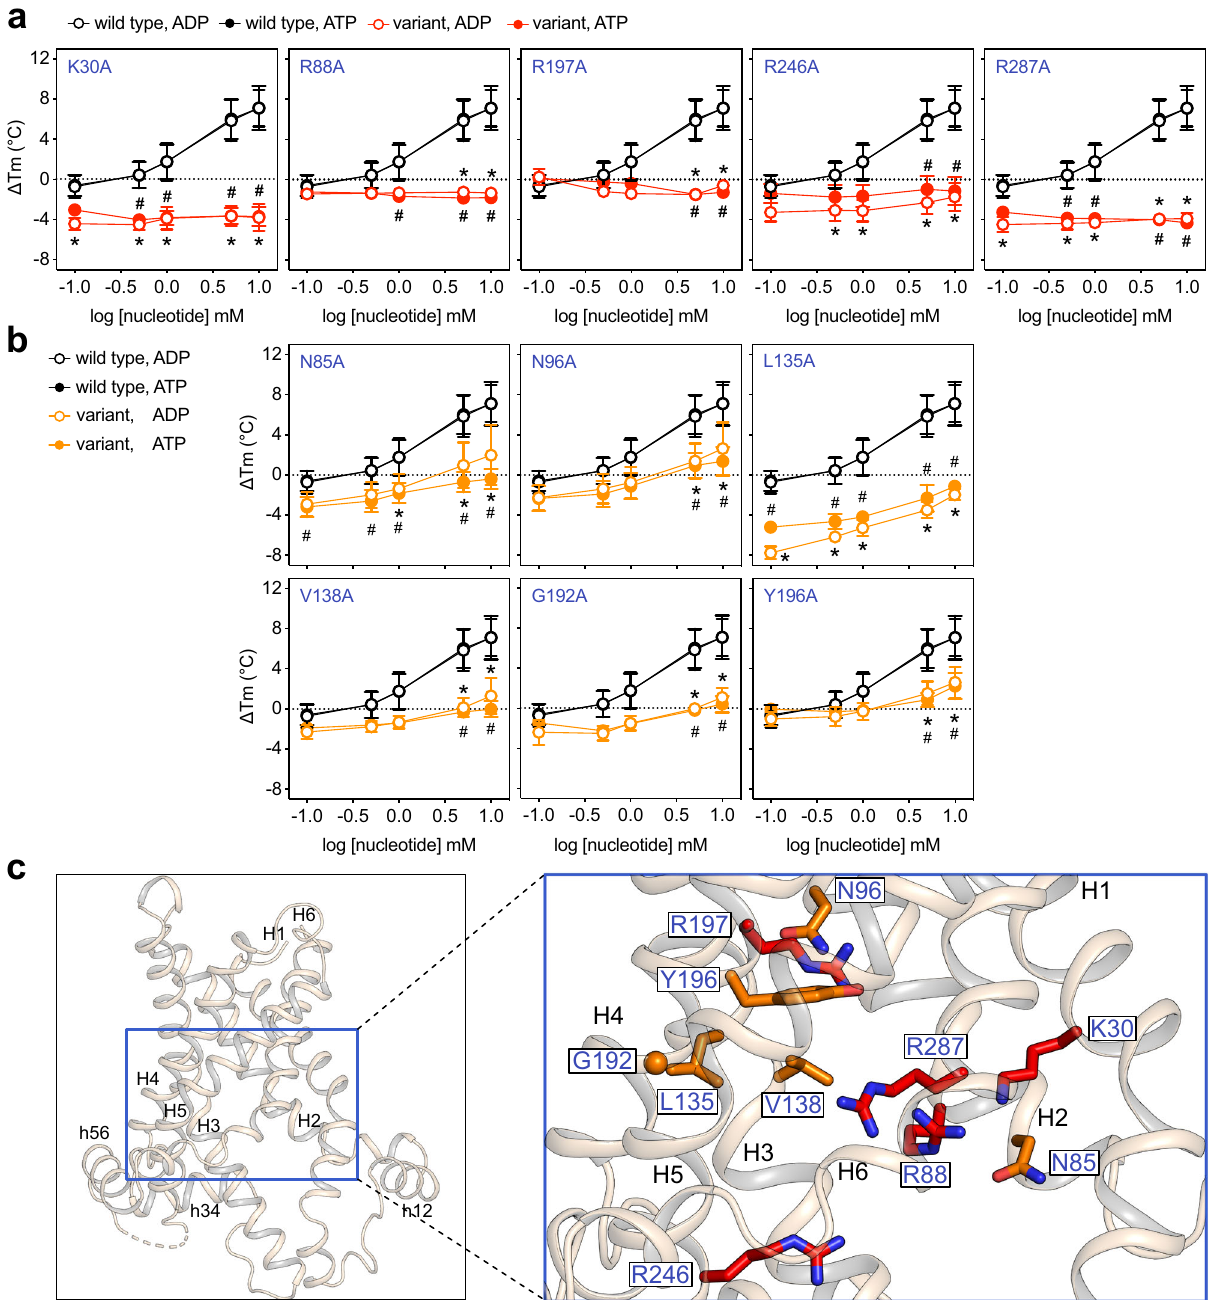
Fig. 4 Five positively charged residues provide critical binding interactions and another six make important contributions. a , b Thermostability shift values ( Δ Tm) determined at 0.1, 0.5, 1, 5, 10mM substrate concentration for the wild type and single alanine replacement variants. Circles and error bars represent the mean and standard deviation of eight independent experiments for the wild type and 3 – 7 for the variants. Empty and fi lled circles represent ADP and ATP, respectively. Data for the wild-type protein are shown in black, whereas those for thevariants are shown in red ( a ) or in orange ( b ) for the critical and important residues, respectively. Note that for several data points the mean value and error bars of ADP vs ATP groups are identical and consequently their graphical representation is superimposed, with the ADP marker on top. Error bars are sometimes masked by the symbol. Signi fi cant differences were evaluated by two-way ANOVA with interaction, as described in “ Methods ” . Signi fi cant values ( p ≤ 0.01) are indicated by * or # for ADP and ATP, respectively. c TtAac matrix-open BKA-bound structure (PDB code: 6gci chain A) (left) and close-up view (right) showing the analysed residues in red or orange stick and sphere for Gly representations. Helices are shown in wheat cartoon representation and are labelled. Source data for this fi gure are provided as a Source Data fi concentration for any of the tested proteins (Supplementary In the case of positively charged residues K30, R88, R197, R246 Fig. 7), both substrates must bind to the same set of residues in a and R287, individual alanine replacements led to the loss of similar way (Fig. 6). Given that ADP/ATP carriers function as function (Fig. 2a) and complete abolishment of the substrate- monomers 14,17,46 – 50 , the import and export steps must therefore induced thermostability shifts (Fig. 4a). Given their chemical be consecutive, implying a ping-pong kinetic mechanism. properties, these residues can be engaging in ionic interactions